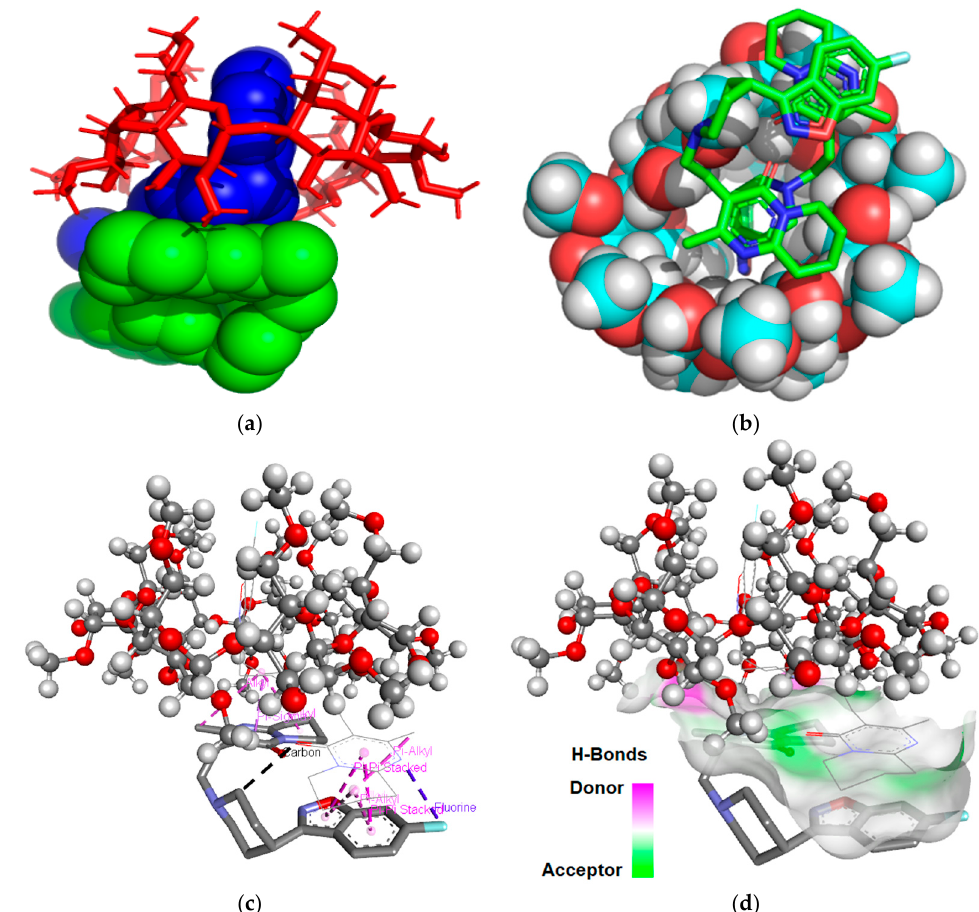
Figure 3. Inclusion complex simulation for a 2:1 molar ratio between RSP and DM- β -CD. Images ( a ), ( b ) show the inclusion complex from the secondary face of DM- β -CD’s cavity. RSP guest molecules are represented in spheres green and blue ( a ), in sticks colored by element ( b ) while DM- β -CD is represented in red sticks ( a ), in sphere colored by element ( b ); image ( c ) shows contacts between RSP and DM- β -CD, RSP is colored by element, DM- β -CD is presented in ball and sticks; image ( d ) show H-bond surface interaction between RSP and DM- β -CD.